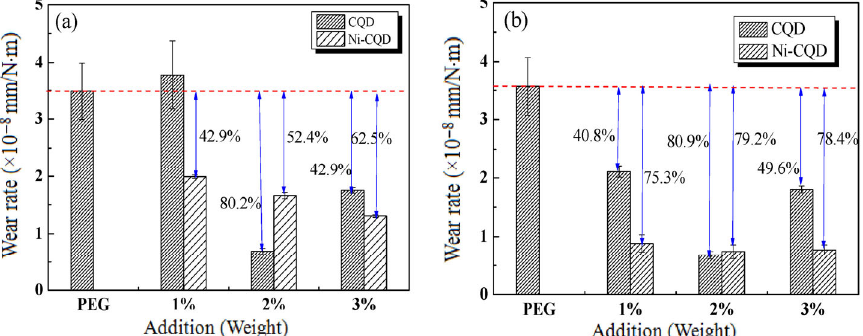
Fig. 8 Variations of wear rates of disks at 100 N for 60 min under the different reciprocation speeds: (a) 17 mm/s; (b) 33